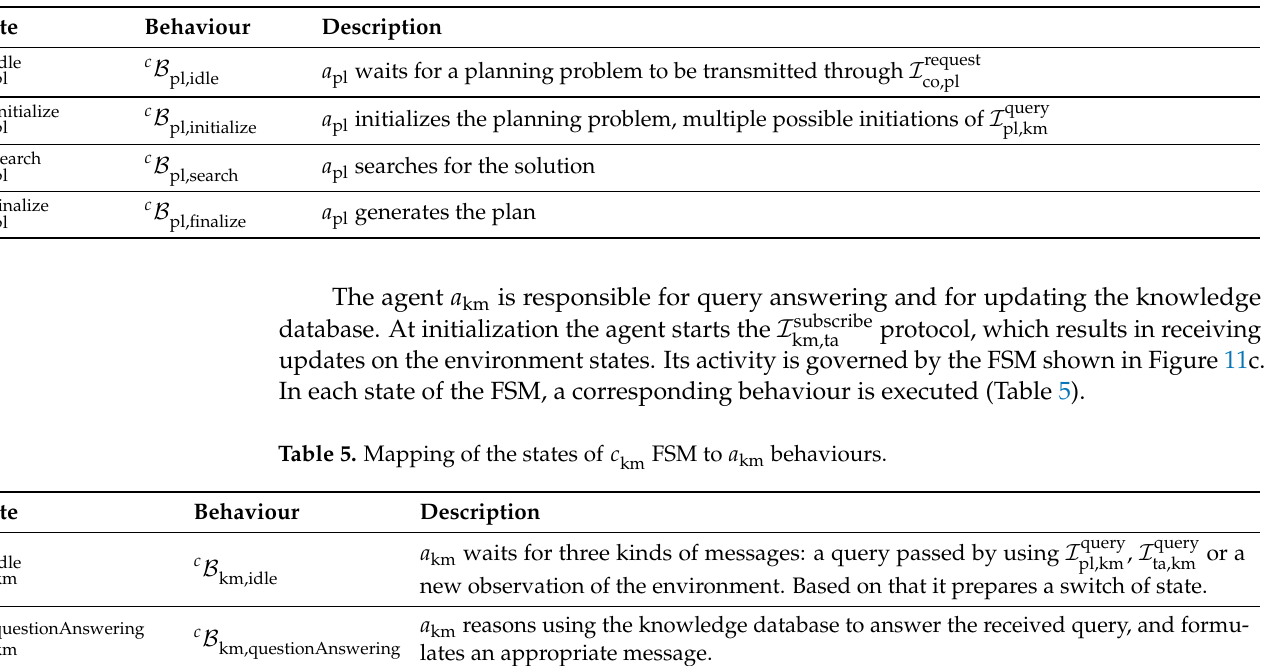
FSM to a pl behaviours. pl